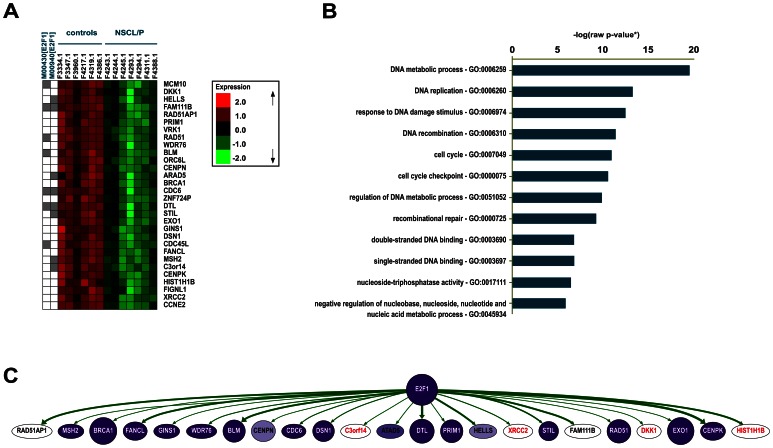
NSCL/P patterns of co-expression are associated with DNA repair, and suggest E2F1 as a regulator.(A) Supervised similarity cluster based on BRCA1 expression (avg. homogeneity = 0.974). Transcription factor binding sites significantly over-represented in the cluster are marked in grey, for each motif identified (Bonferroni-adjusted p-value <0.05). (B) GO attributes enriched in the similarity cluster and their respective representation among the 30 clustered genes, expressed in percentages ([*] Bootstrap-adjusted p-values = 0.001, raw p-values were used in the chart). (C) Analysis of transcription factor-gene interactions. ChIP-chip data from FANTOM4 were used to validate the interaction between E2F1 and 23 out of the 30 genes of the similarity cluster. The thickness of the arrows indicates how often the interaction has been experimentally detected; node colours represent the level of expression in the cell lines used to assemble the database, from low (light) to high (dark).